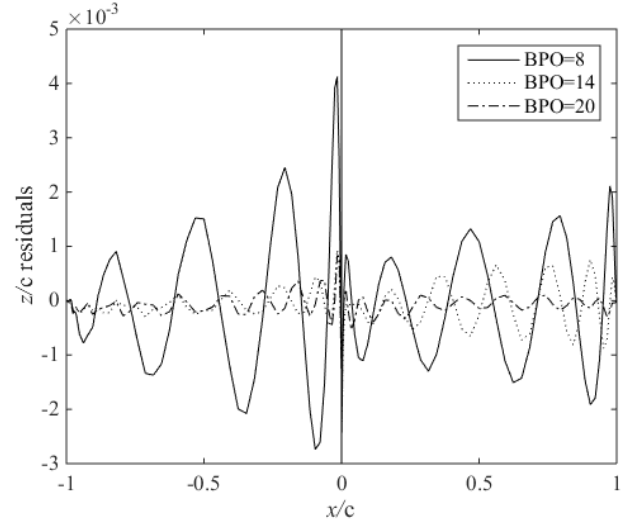
Figure 9. CST parameterization residuals of the S1223 airfoil.